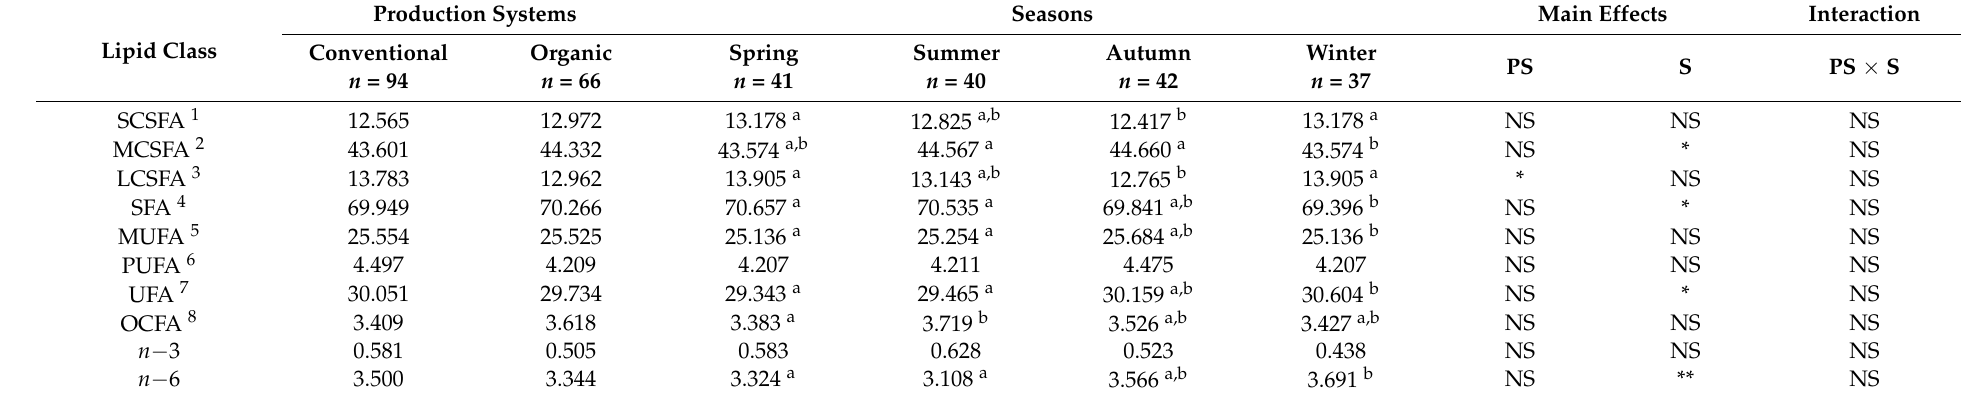
Table 5. Effects of production system and season on milk lipid classes (% of total identified fatty acids) and p - values for the main effects and their